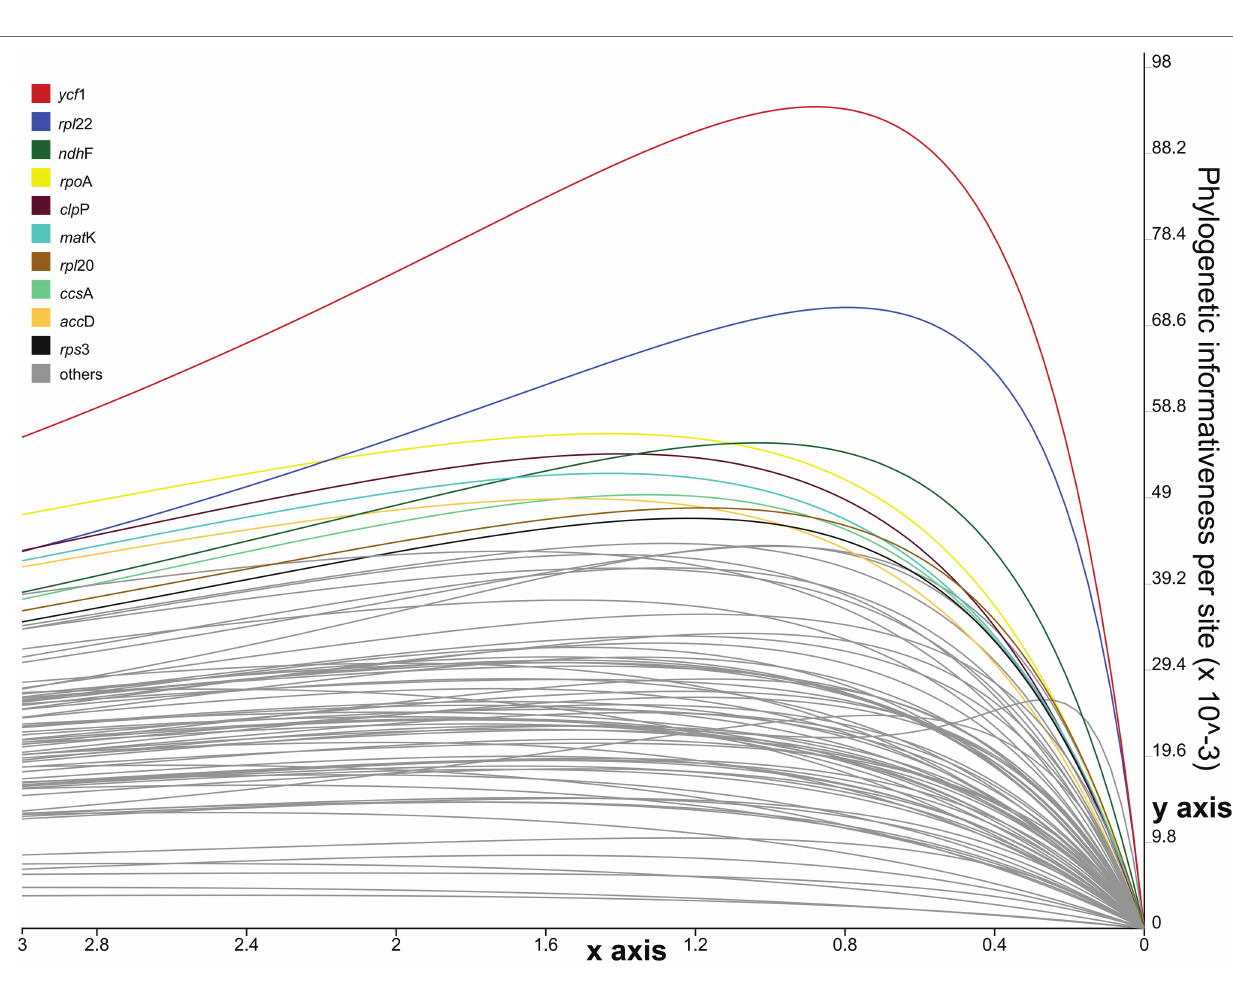
FIGURE 6 | Phylogenetic informativeness per-site profiles of 76 coding sequences (CDSs) of Euphorbia estimated in PhyDesign. The 10 most informative CDSs are color-coded and indicated at the left. x - and y -axes represent relative-time and phylogenetic informativeness per site,